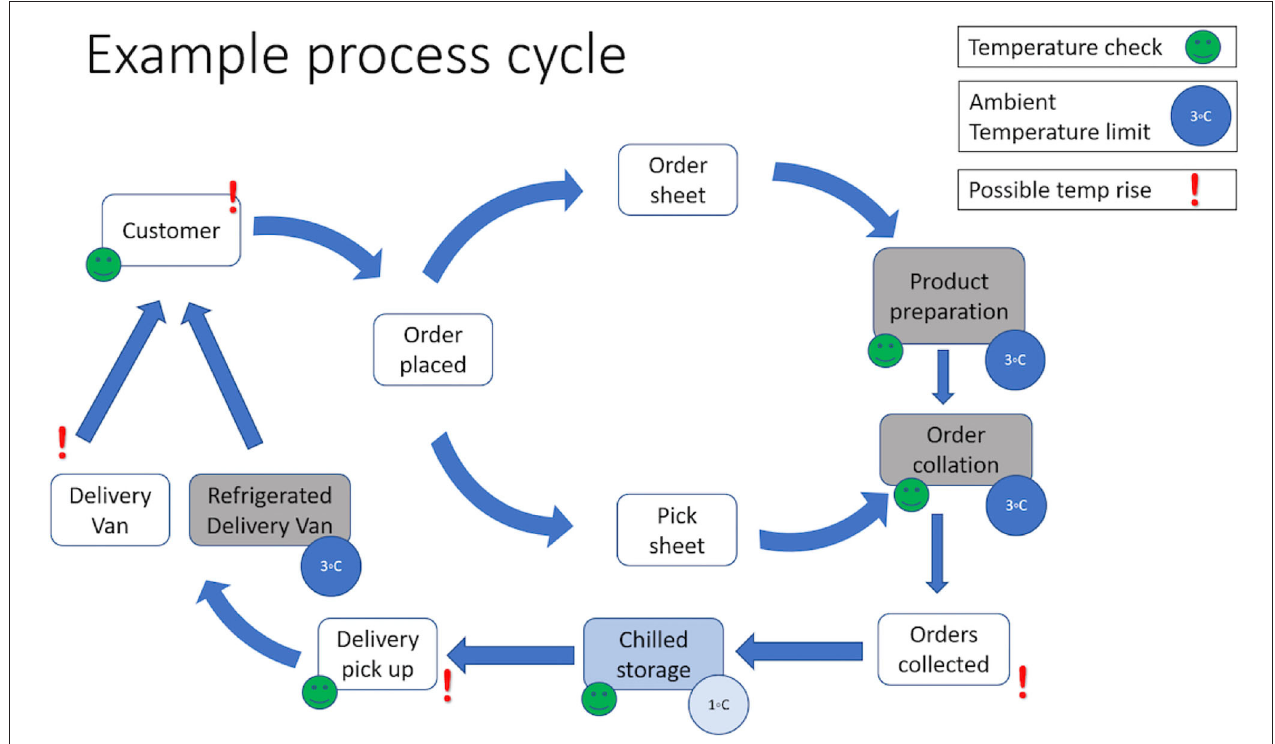
FIGURE 2 | An overview of the main delivery steps derived from on-site observations with project business partners.